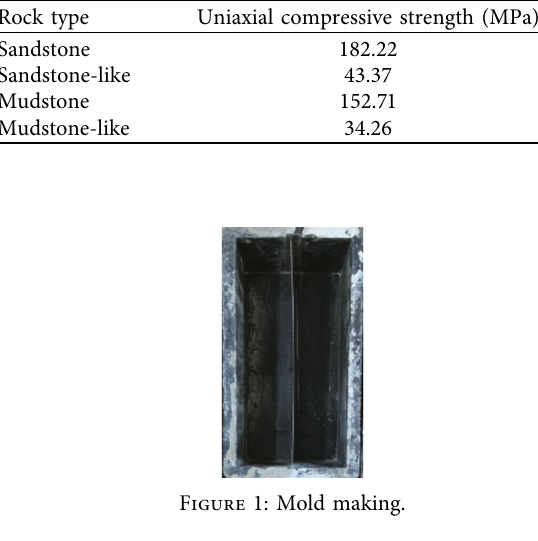
Table 1: Main physical and mechanical parameters of original rock and similar rock specimens.